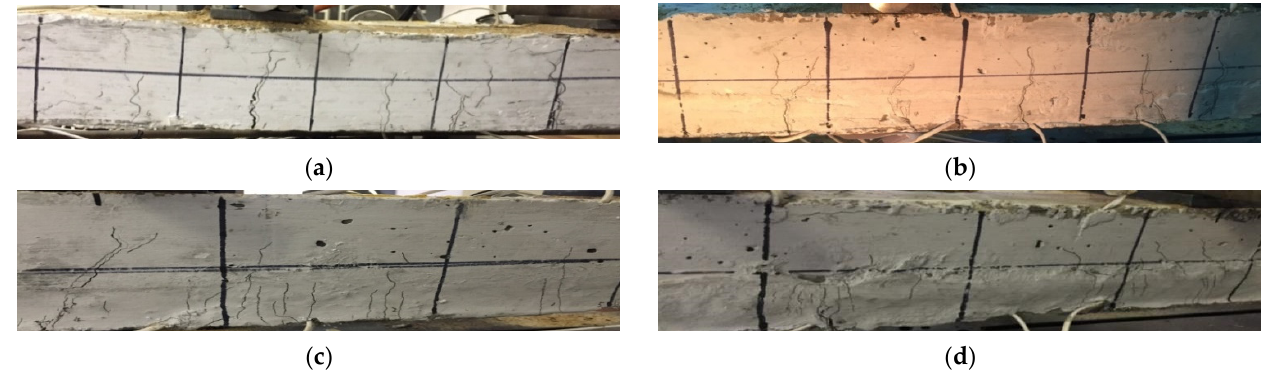
Figure 8. Failure modes of specimens. ( a ) SJ-1; ( b ) SJ-2; ( c ) SJ-3; ( d ) SJ-4.